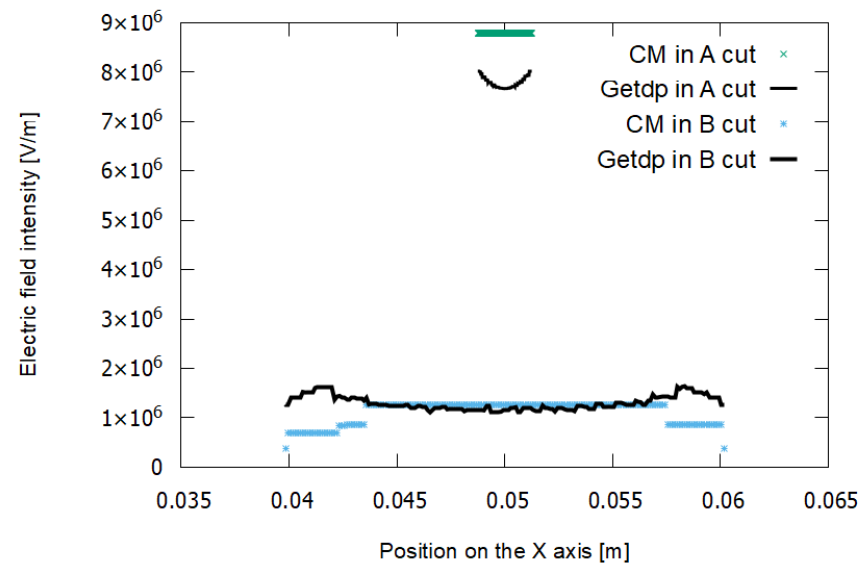
Figure 14. Electric field in cut A (upper curves) and cut B (lower curves) for experiment E1.